Question: State the chart type depicted above.
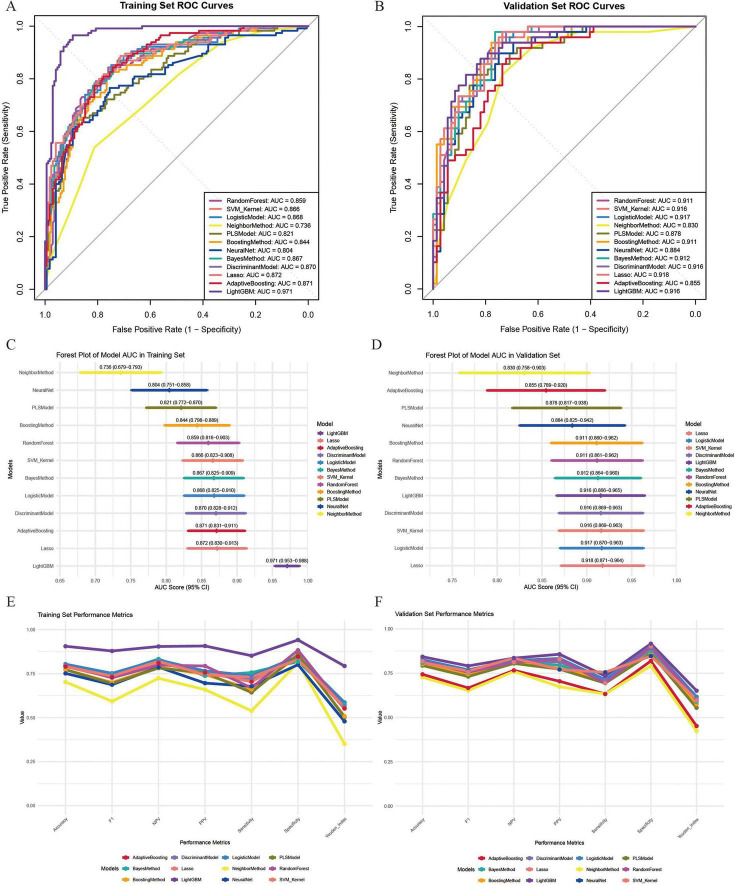
Answer: forest